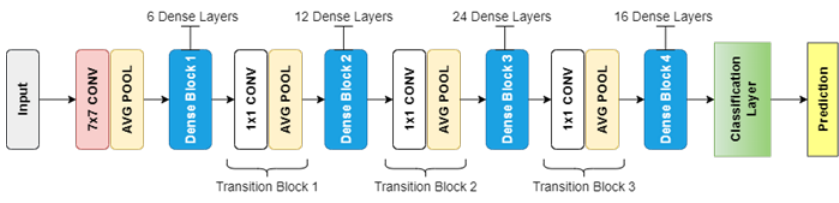
Figure 6. DenseNet-121 general architecture.